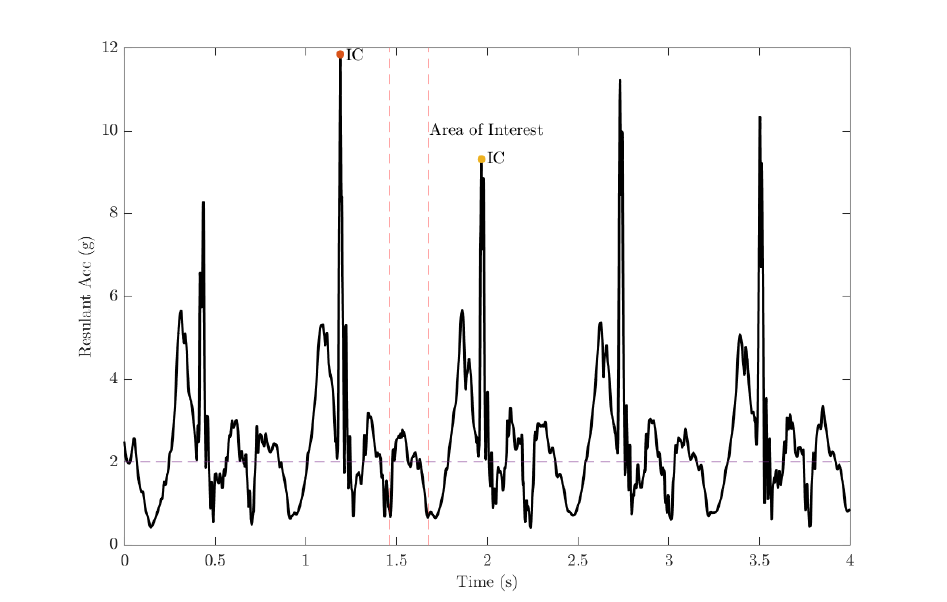
Figure 2. Random samples of right ankle acceleration value in g A ankleR of a participant during 85% maximum speed running. Please note that the peak resultant acceleration is marked as IC, and the 2 g-threshold is the area of interest for TC detection.